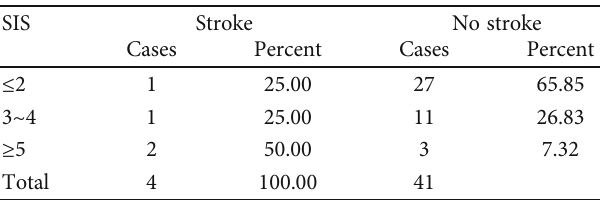
Table 8: Comparison of SIS scores between the two groups with and without stroke.